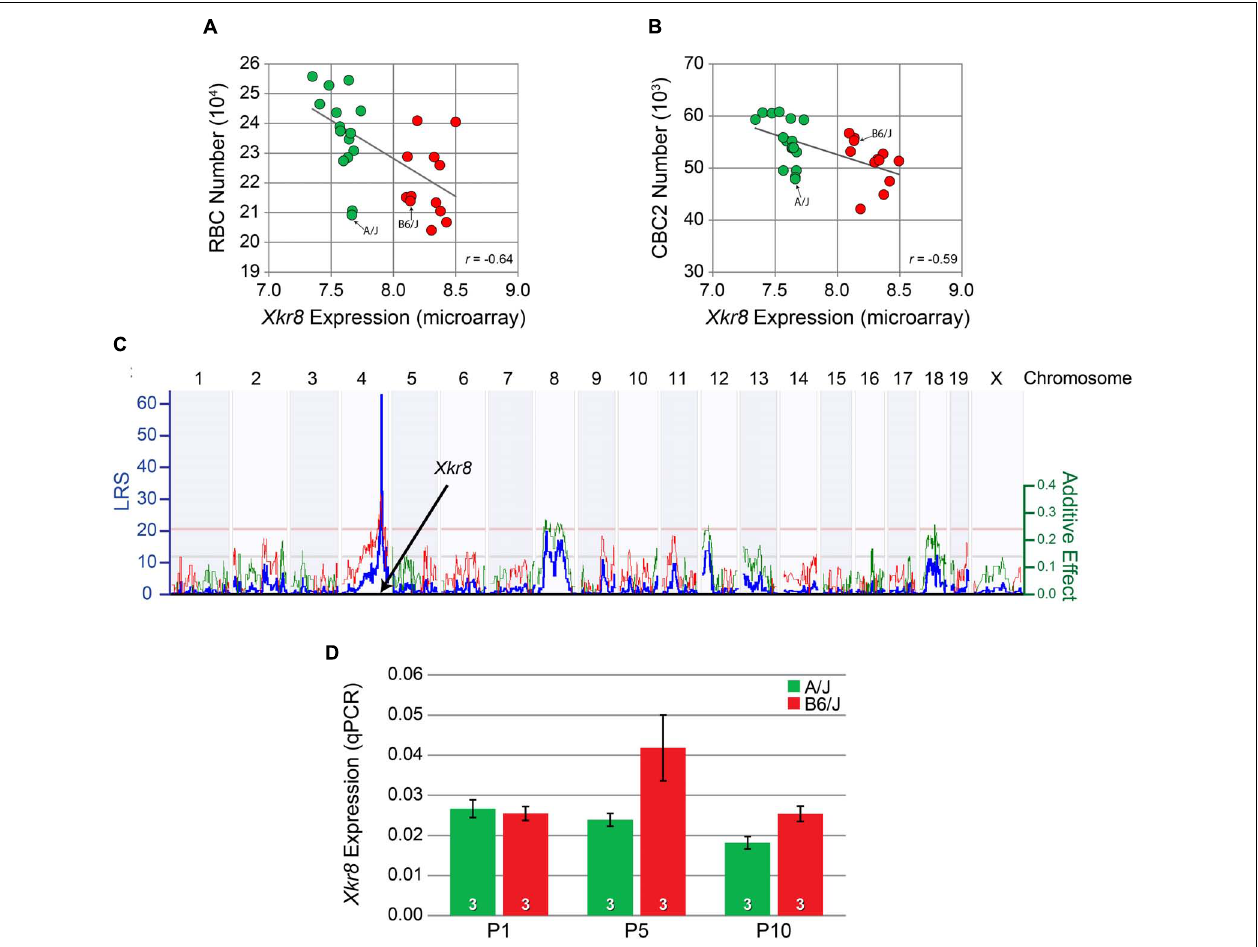
FIGURE 5 | Xkr8 expression was negatively correlated with both RBC number (A) and CBC2 number (B) across the RI strain set. Those strains carrying the B haplotype at the Xkr8 locus (red) all had lower transcript levels relative to strains carrying the A haplotype (green). Expression in each of the parental B6/J and A/J strains is also indicated. (C) The variation in expression of Xkr8 across the RI strains mapped to the same genomic locus for bipolar cell number, indicating the presence of a variant in Xkr8 affecting gene expression (i.e., a cis -eQTL). (D) qPCR for Xkr8 transcript levels showed significantly greater developmental expression in the B6/J strain relative to the A/J strain ( p < 0.05), being most conspicuously greater at P5. Retinal mRNA was pooled from individual eyes in each litter, at each time-point. n = the number of litters per strain examined at each